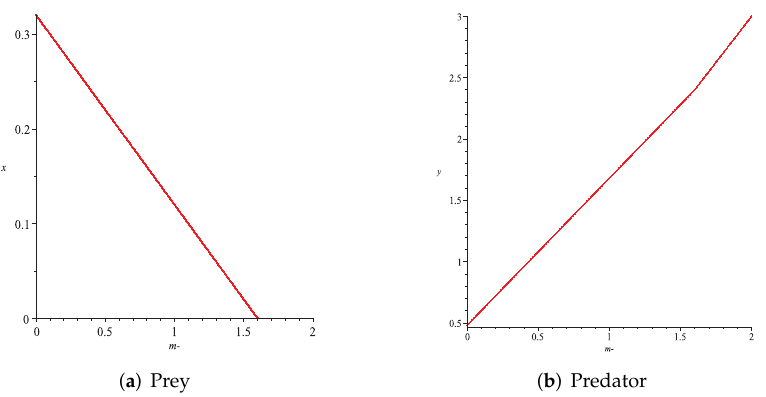
Figure 12. Variation of prey and predator densities with parameter m ( k = 0, r 0 = 1.5, h = 1.5).